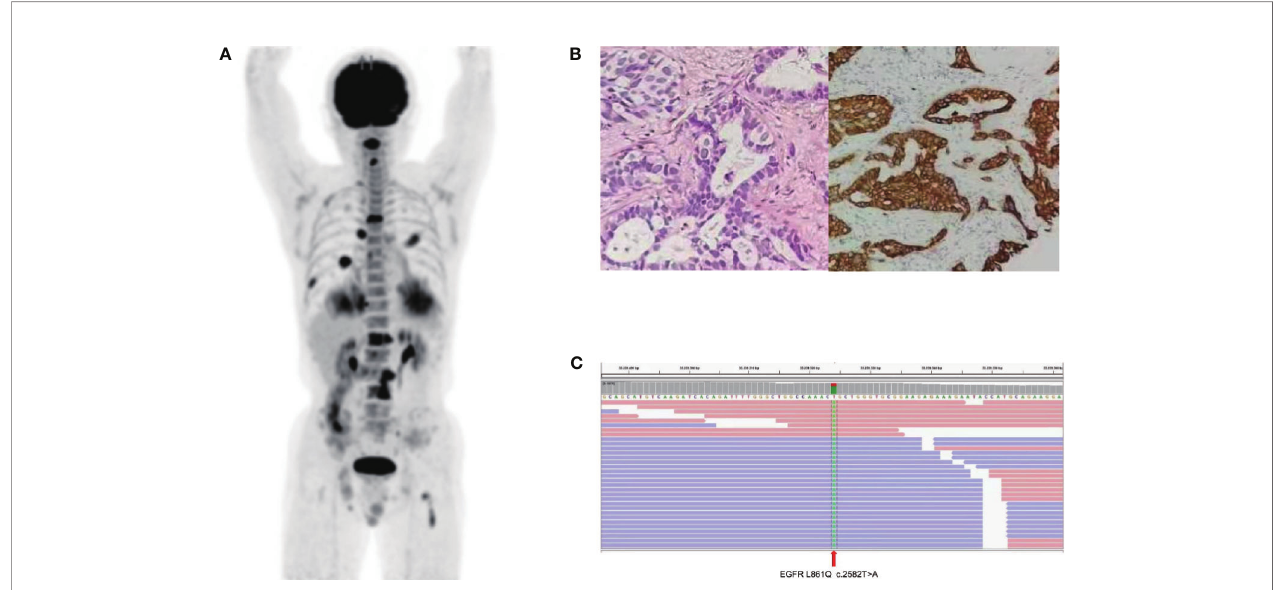
FIGURE 1 | Baseline data: (A) Positron emission tomography-computed tomography (PET-CT) image. (B) Representative histopathological image of the tumor (H&E staining). (C) Next-generation sequencing showed an L861Q mutation in the epidermal factor receptor exon